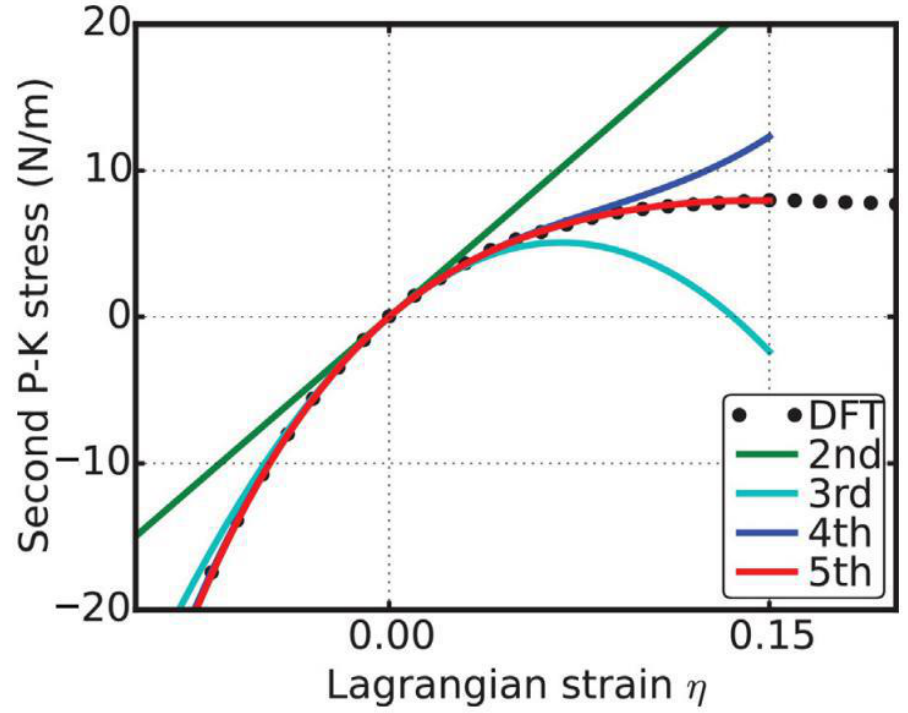
Figure 20. Order effect. Predicted stress–strain responses of biaxial deformation of g-InN monolayer from different orders (second, third, fourth, and fifth order) compared to that from the DFT calculations (circle line).